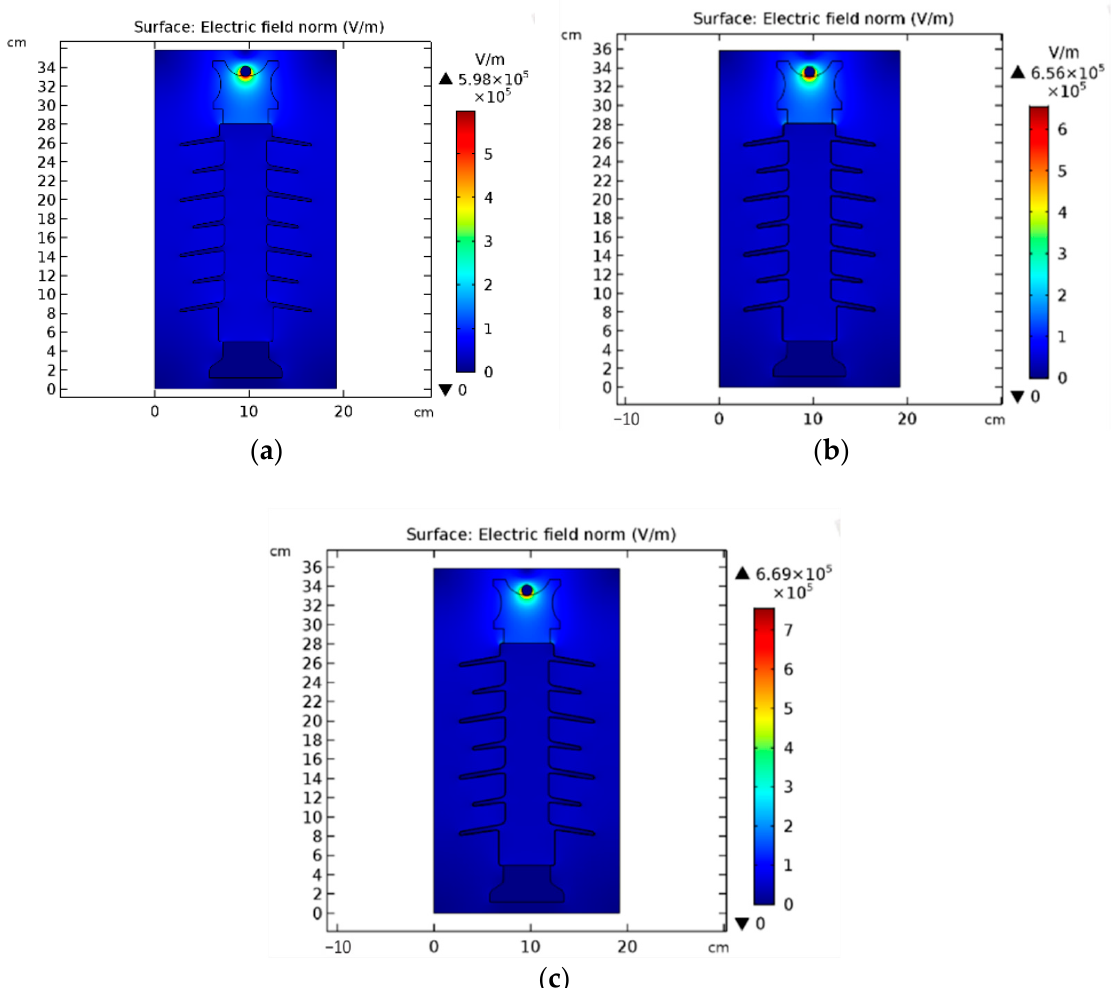
Figure 14. Distribution of electric field on insulator ( a ) without contaminant, ( b ) with salt contaminant, and ( c ) with fly ash contaminant.